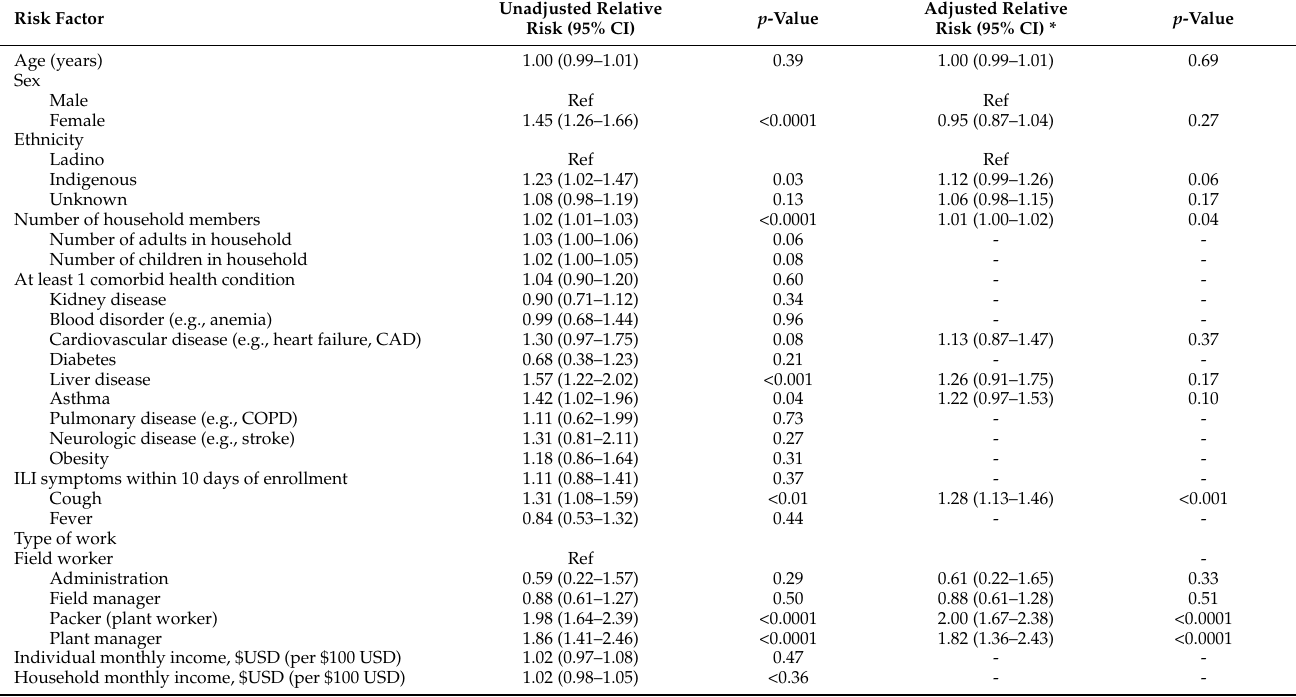
Table 2. Unadjusted and adjusted * associations between risk factors and SARS-CoV-2 seroprevalence at enrollment among enrolled cohort participants with baseline serology, Guatemala ( n =